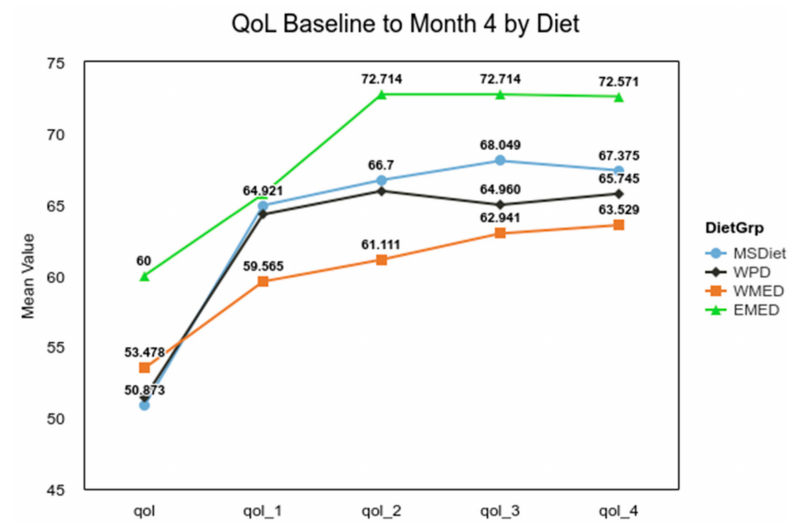
Figure 3. QoL by diet pattern over 4 months. Note. MS Diet = MSDiet, Western Pattern Diet = WPD, Western Mediterranean = WMED, and Eastern Mediterranean Diet =